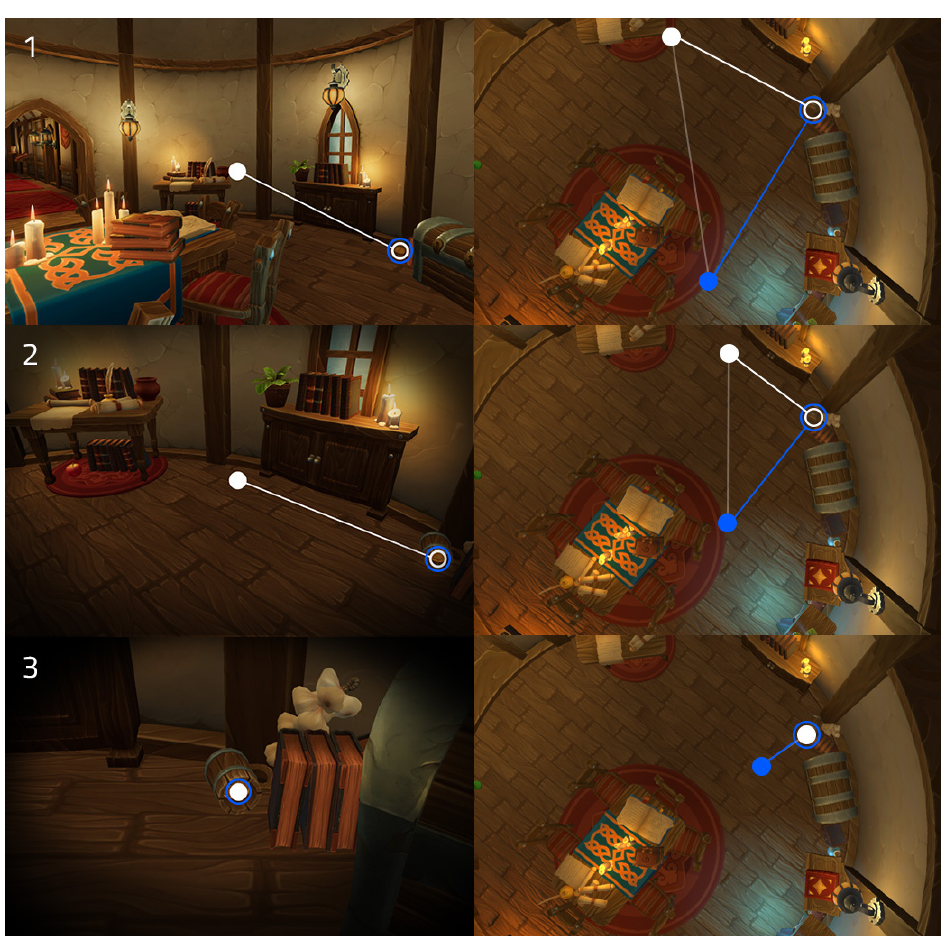
Figure 4. A step-by-step example of the gaze-based guidance process: left column—player view; right column: top-down view of the level; Circles with white filling color: crosshair, circles with blue and white outlines: current gaze position of player; circles with blue filling colour: current player position; first row: the player looks at a gaze sensitive areas from afar; second row: the player reduces his/her distance between him/her and the target area and fixates the target; the third row: the player looks at the target and is near the hidden object. The distance between the player and the target and the distance between the current gaze position relative to the target drives the vignette